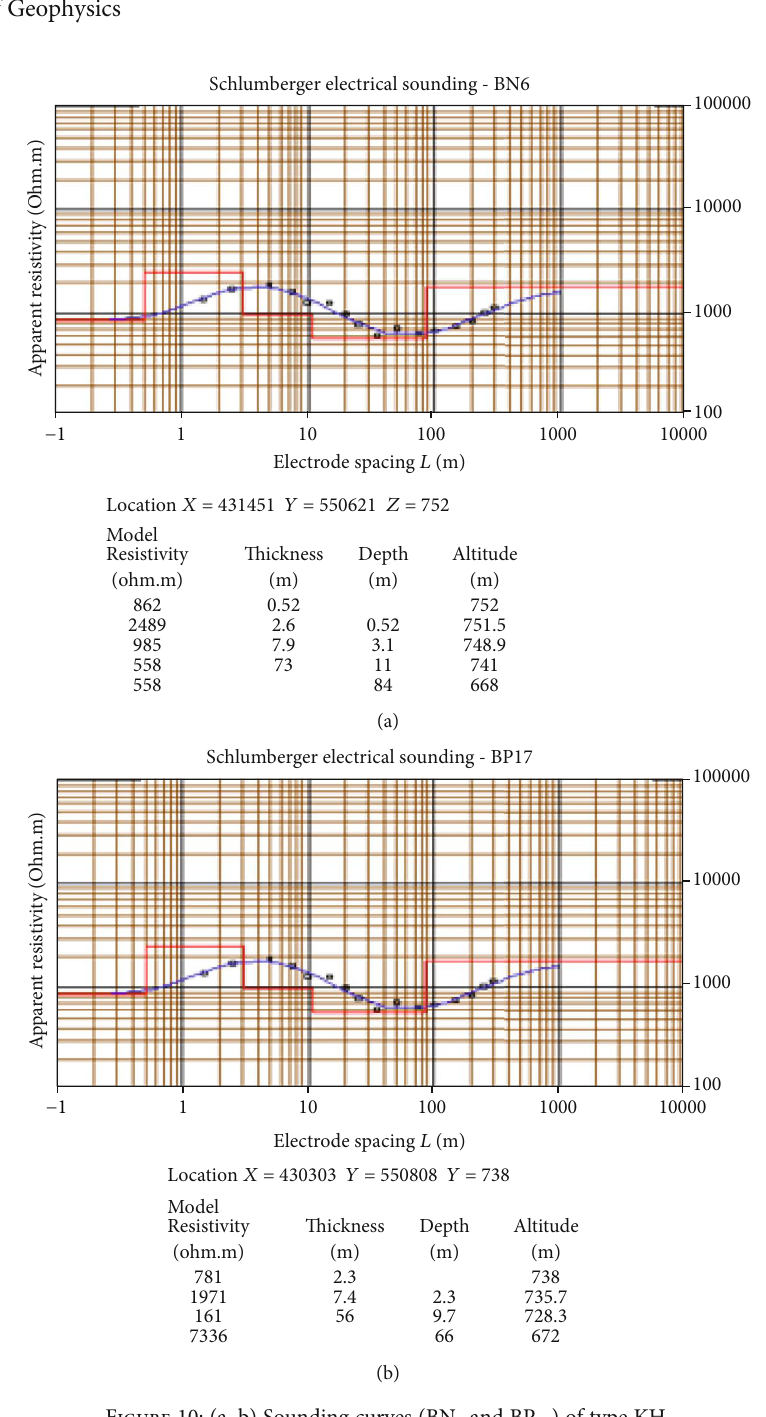
and BP ) of type 6 17